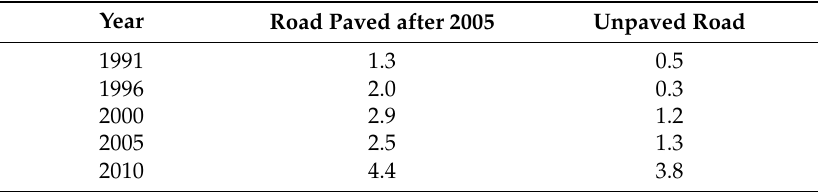
Table 1. Percentage of deforested pixels for each year and road